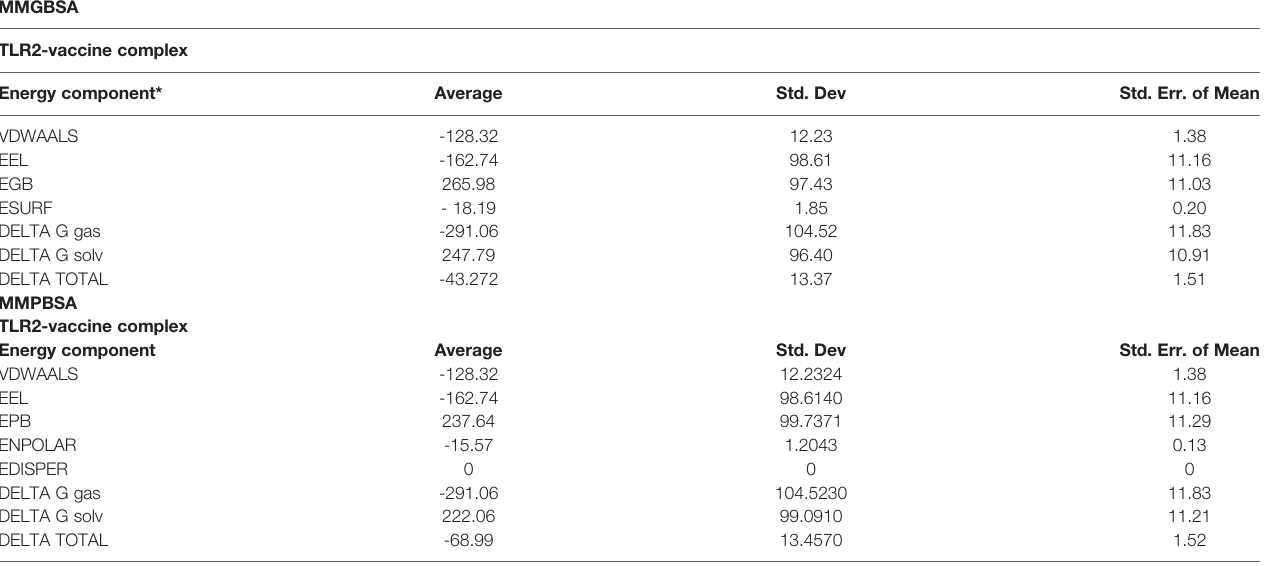
TABLE 6 | Free energy of binding, estimated by MMGBSA and MMPBSA for the